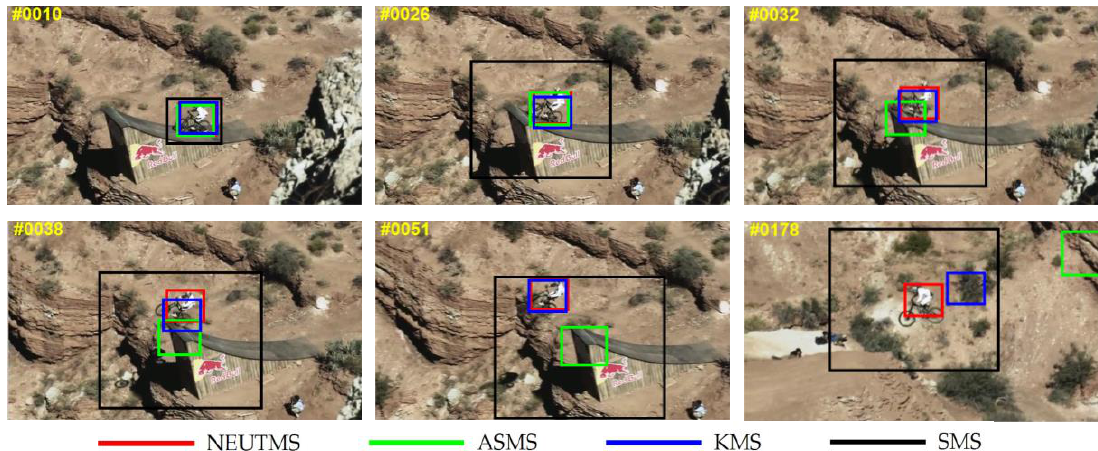
Figure 2. Screenshots of tracking results of the video sequence used for testing ( mountainBike , target is selected in frame #1).